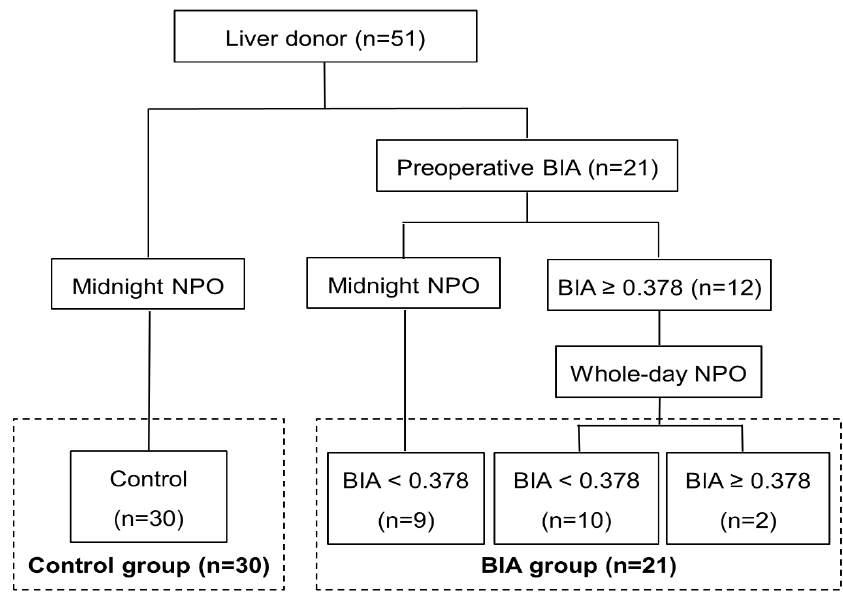
Figure 1. Flow diagram of the study. Among 51 living donors, the first 30 consecutive donors were enrolled in the control group, and the next 21 donors with preoperative BIA were enrolled in the BIA group. Donors with ECW/TBW ≥ 0.378 had whole-day NPO, whereas those with ECW/TBW < 0.378 had midnight NPO, similar to the control group. BIA was selectively performed again on the operative day for donors with ECW/TBW ≥ 0.378 to analyze the changes in the value after whole- day NPO. BIA, bioelectrical impedance analysis; NPO, nothing by mouth. 2.2. Data Collection Age, sex, presence of diabetes mellitus or hypertension, body mass index (BMI), type